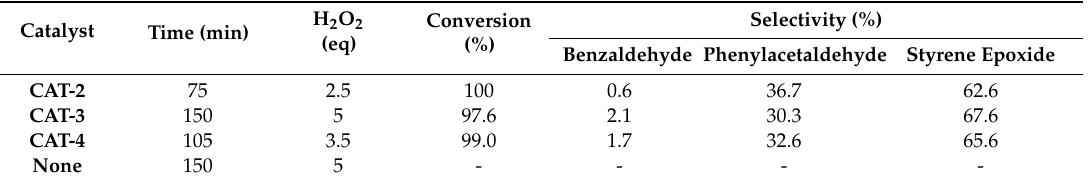
Table 5. Results obtained for the oxidation of styrene with H 2 O 2 using CH 3 CN as the solvent and ammonium acetate as the co-catalyst (a)